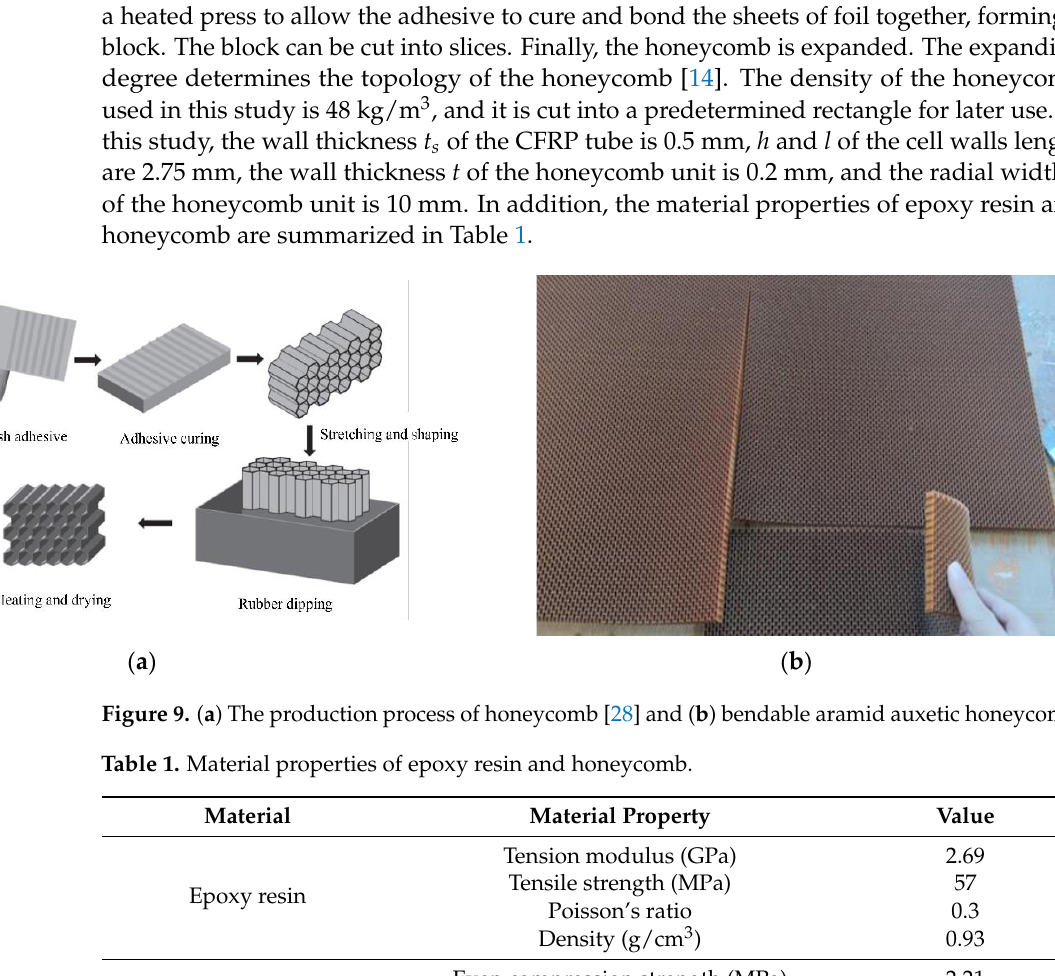
Figure 8.(a) Textile structure of braided tubular fabric and (b) schematic diagram of the weave of carbon fiber tube [27].